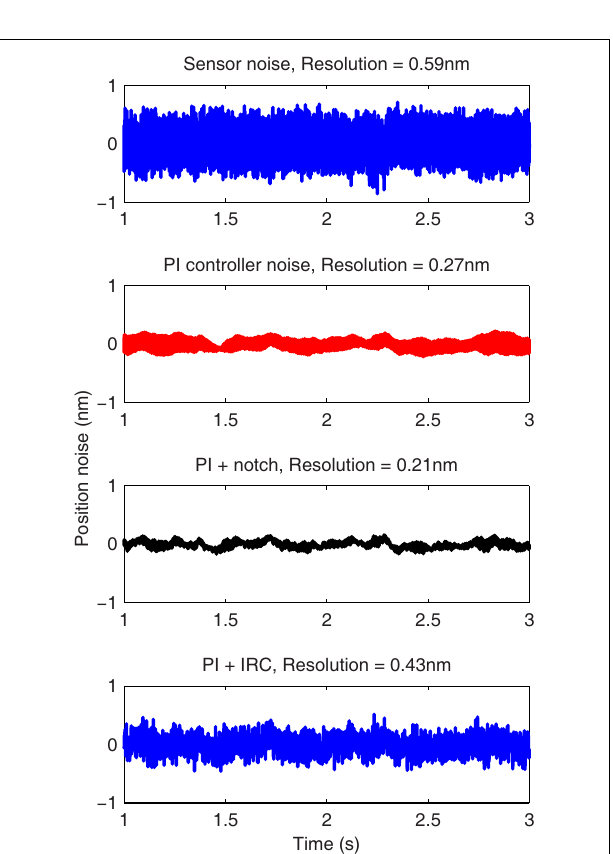
FIGURE 9 | The closed-loop noise of each control strategy and the corresponding 6 (cid:27) -resolution . controller is plotted in Figure 9 . While the PI and inverse con- troller noise contains low-frequency noise plus randomly excited resonance, the IRC controller resulted in a more uniform spec- trum but with a wider noise bandwidth. Considering that the IRC controller increases the closed-loop bandwidth from 5 to 78 Hz (compared to PI control), the decrease in resolution from 0.27 to 0.43 nm is